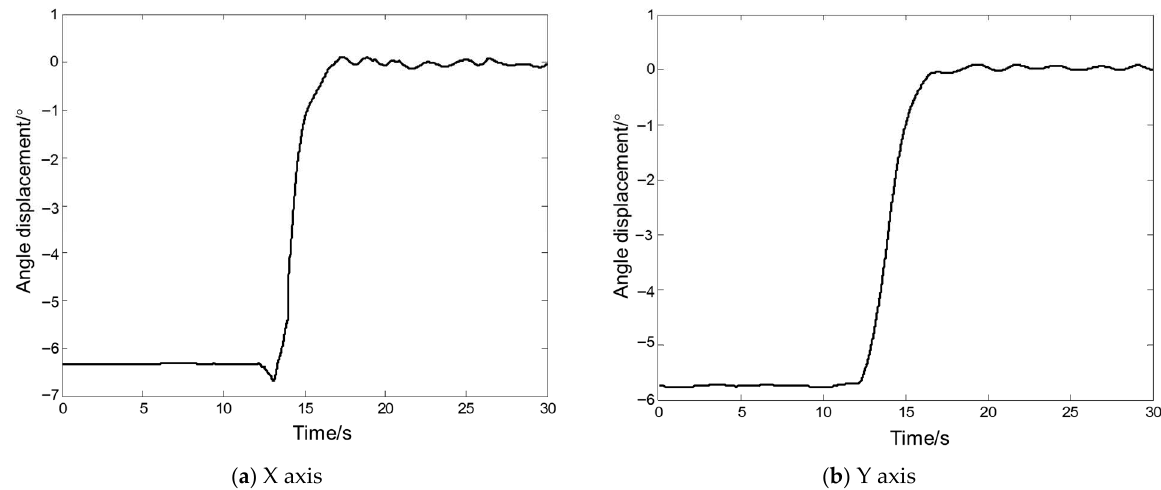
Figure 17. Large angle attitude levelling curve of the drifting platform without wave disturbance.